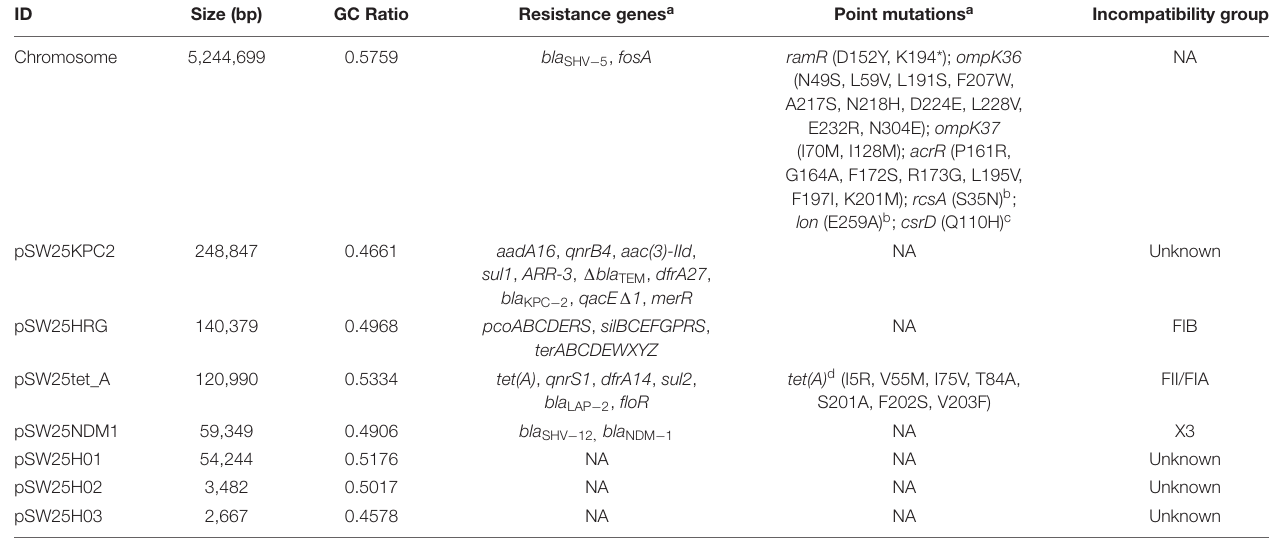
TABLE 2 | Genomic characterization of AHSWKP25.